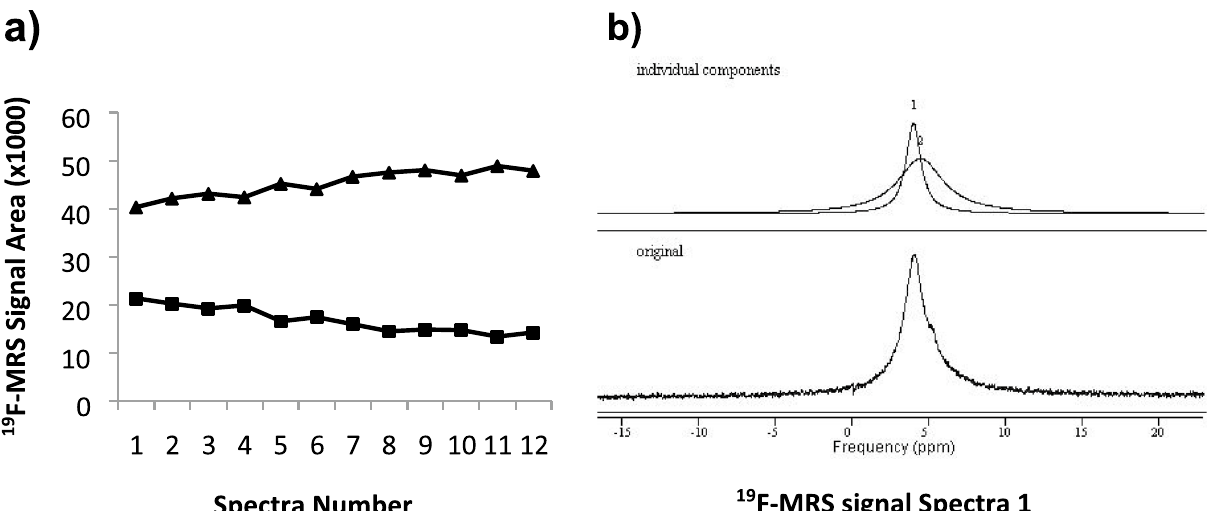
Figure 5. Ex-vivo (perfusion) and in-vivo conversion of keto compound c1a to hydroxy metabolite c1b detected by 19 F-MRS scanning of liver in rat. ( a ) Ex‑vivo scan of perfused liver. Signal areas versus spectrum on the serial scans of the pilot experiment, each for 400 s, beginning ~ 20 min after the end of a 30 min perfusion with c1a 100 µM solution. c1b was formed and accumulated rapidly during the perfusion. Generation of c1b from c1a continued to happen in the excised liver during scanning. ( b ) The 19 F-MRS spectra reveals further broadening of peaks compared with scanning in blood (representative spectrum 1 and signal deconvolution shown), with the overlap of wide signals from tracer and metabolite seen across all scaling factor of 4.4 between 3 and 7T instruments offering future possibilities for improvement. Difficulties in detection could also potentially could be overcome by polyfluorinated tracers, should they be licensed for human use. However it is worth also noting that here, using licensed doses of dexamethasone, the circulating concentra- tions of dexamethasone achieved were substantially lower than the concentrations of other fluorine-containing drugs detected successfully by MRS. Indeed, although doses of dexamethasone used here were as high as might reasonably be used in healthy volunteers, they do not approach the doses of other (often poly-fluorinated) drugs used for previous 19 F-MRS studies (> 500 mg 22,25,28 ). The limited scope to further increase dosing of monofluori- nated steroids was unlikely to yield the sensitivity gains required. The detection of (and resolution between) 19 F-MRS signals from structurally very similar tracer and metabolite, achieved using the readily available and suitable for human fluorinated molecule dexamethasone and on a clinical scanner set up, was still a promising finding particularly in view of the low LOD F measured using relatively short acquisition times.